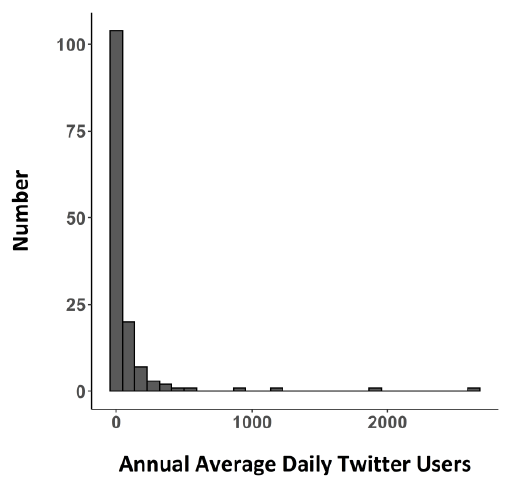
Figure A4. Histogram of the annual average daily Twitter users.